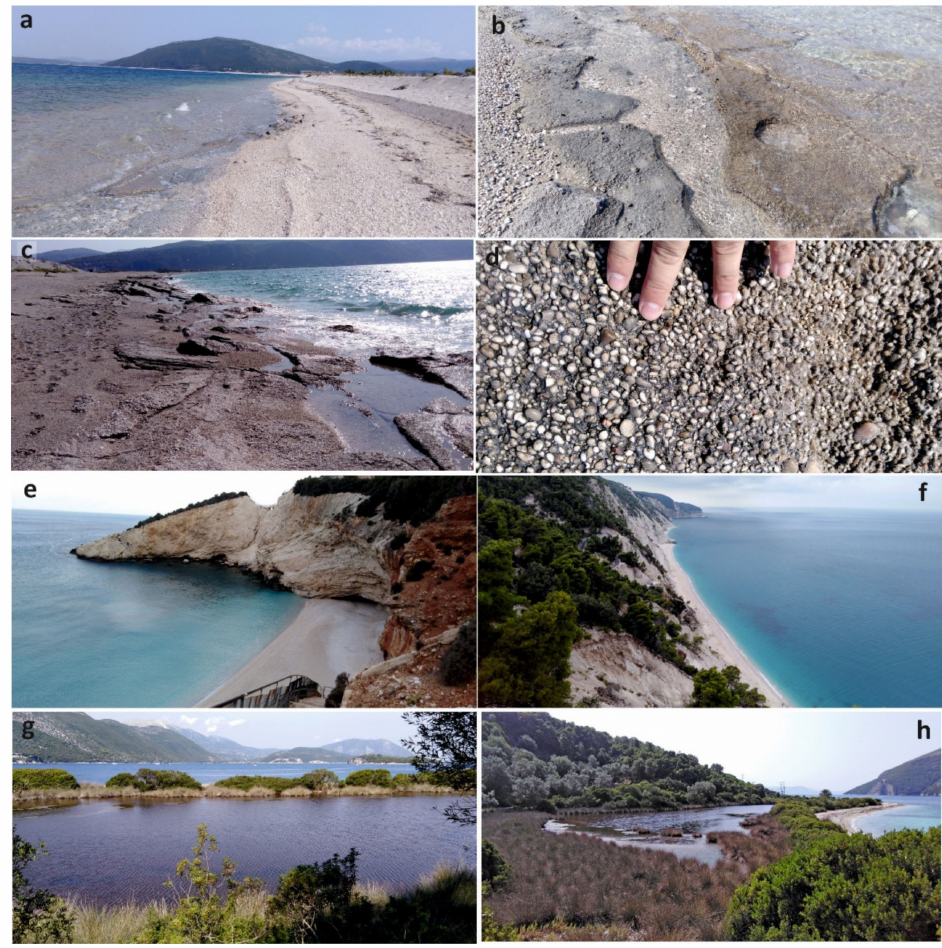
Figure 6. Selected geosites on Lefkas island, for coding see Figure 4: ( a ) Gyra spit (L02); ( b ) beach rocks at Gyra (L02); ( c ) beach rocks at Ag. Ioannis (L02); ( d ) beach rocks at Ag. Ioannis (L02), detail of the glassy texture; ( e ) Moutlou/Porto Katsiki beach (L14); ( f ) Egremnoi beach (L13). Selected geosites on Meganisi island, for coding see Figure 4. ( g , h ) Aghios Ioannis lagoon (M01). Photos ( a – h ) courtesy E.